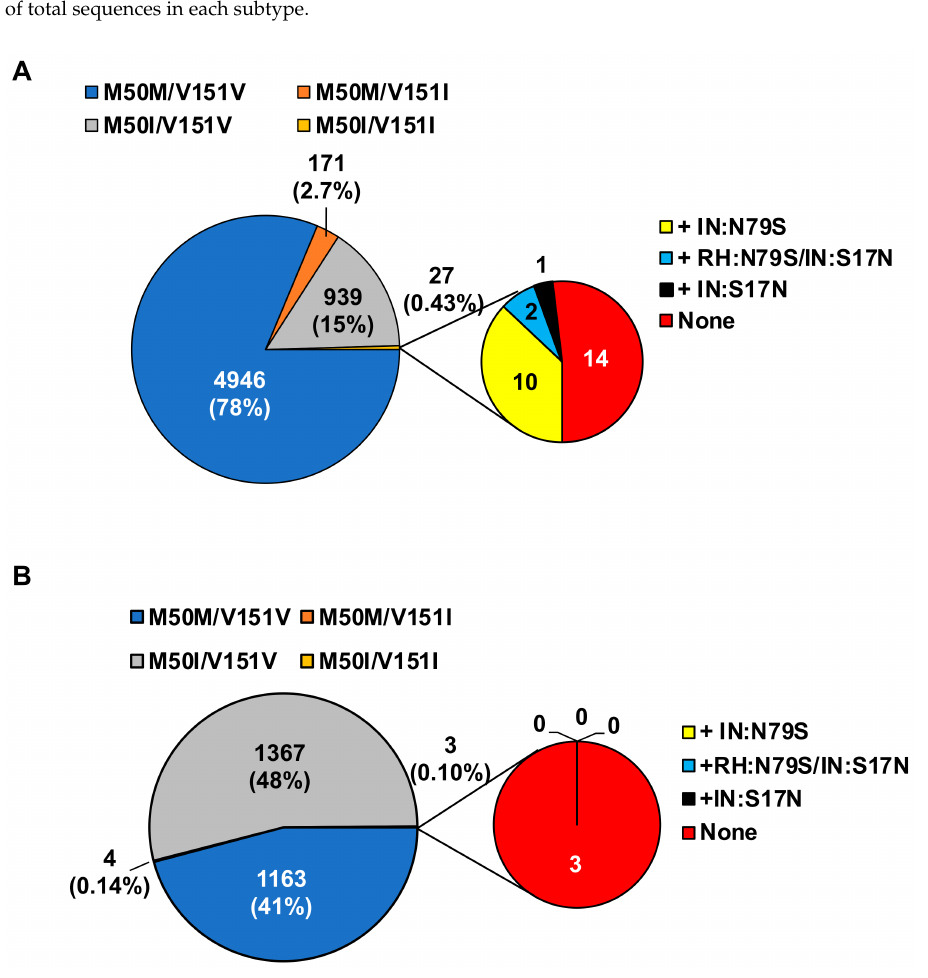
Figure 4. Population diversity of a combination of IN:M50I/IN:V151I mutations in subtype B and C HIV in the LANL HIV database. Population analysis was conducted to determine the diversity of HIV sequences containing IN:M50I and IN:V151 in ( A ) subtype B and ( B ) subtype C in the LANL HIV database. All HIV-1 subtypes of sequences were downloaded from the LANL.GOV website. The sequences containing IN (P31) regions were selected and only one sequence per patient was used in the population analysis. As shown in Table 3, total 27 and 3 of HIV sequences contained the lethal combination in subtype B and C, respectively. The sequences containing the defective mutations were further analyzed to define a population of RH:N79S and